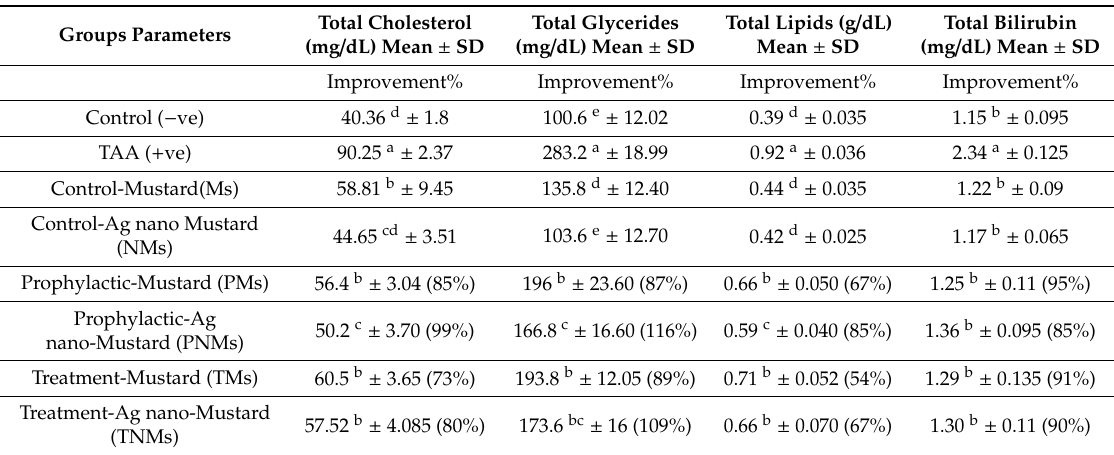
Table 3. Restorative and prophylactic impacts of Brassica juncea L. (mustard) extract in its normal and its nanostructure on lipid